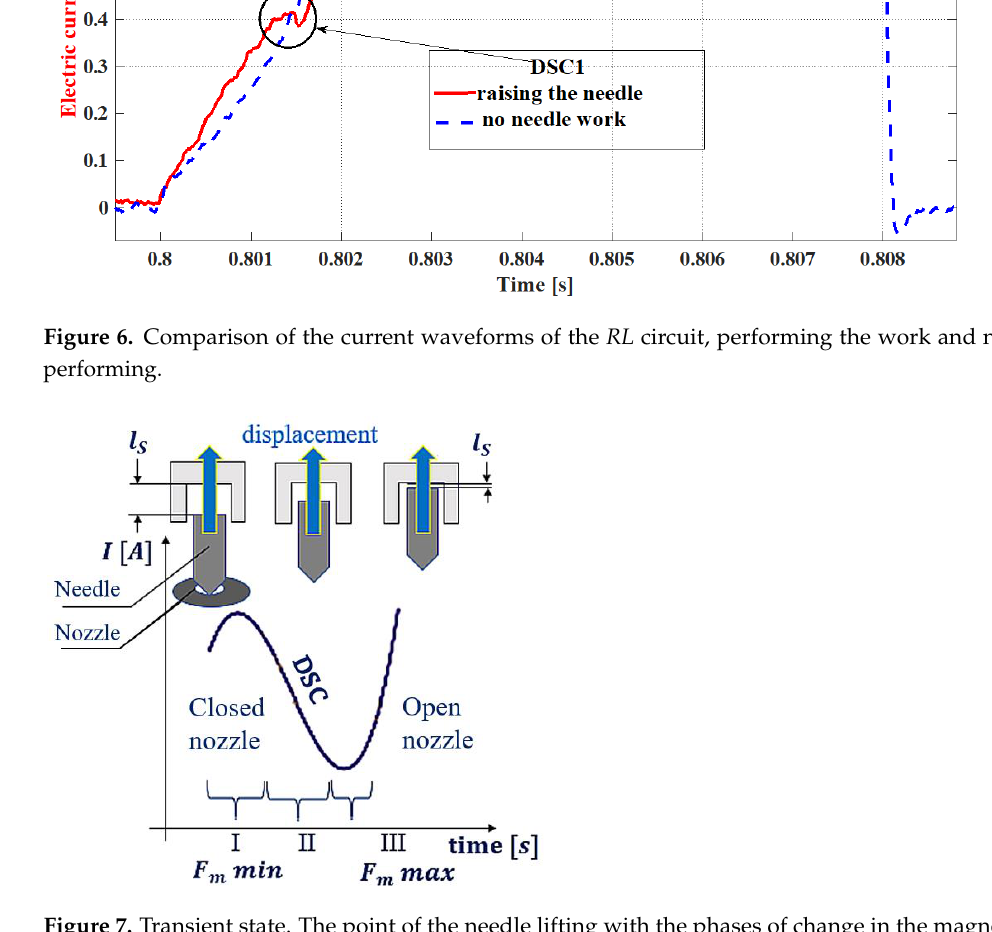
Figure 7. Transient state. The point of the needle lifting with the phases of change in the magnetic force 𝐹 𝑚 , gap, and current intensity. Duration: ~ 100 μs .